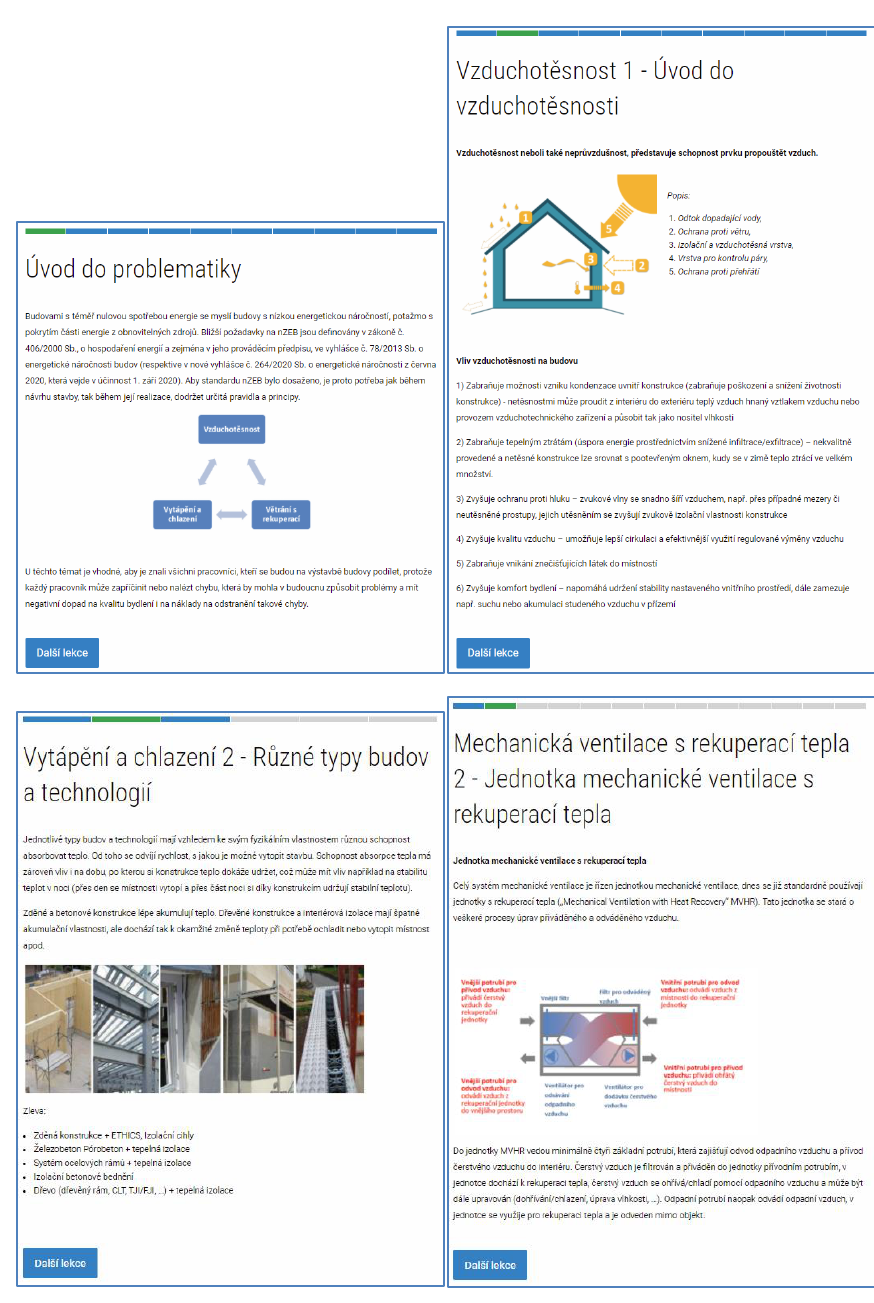
Figure 4: E-learning course – forms of the e-learning course pages – for the Czech variant (source: authors) The quiz evaluates the answers for the user, and he knows which questions he answered incorrectly (red color). The participant obtains the information he/she must add to successfully complete the course. Quizzes are positioned so that it always after the closing of the thematic area. They help the participant to understand the basic information of the issue. Quiz questions take various forms. They can look like a simple question with one correct answer or question with more than one correct answer than user must mark them all. Furthermore, the questions may look like a blind table, where the user must correctly assign the answers to the correct columns and rows. Last but not least, there are very interesting questions for compiling the right order. These questions are mainly used for questions related to technological